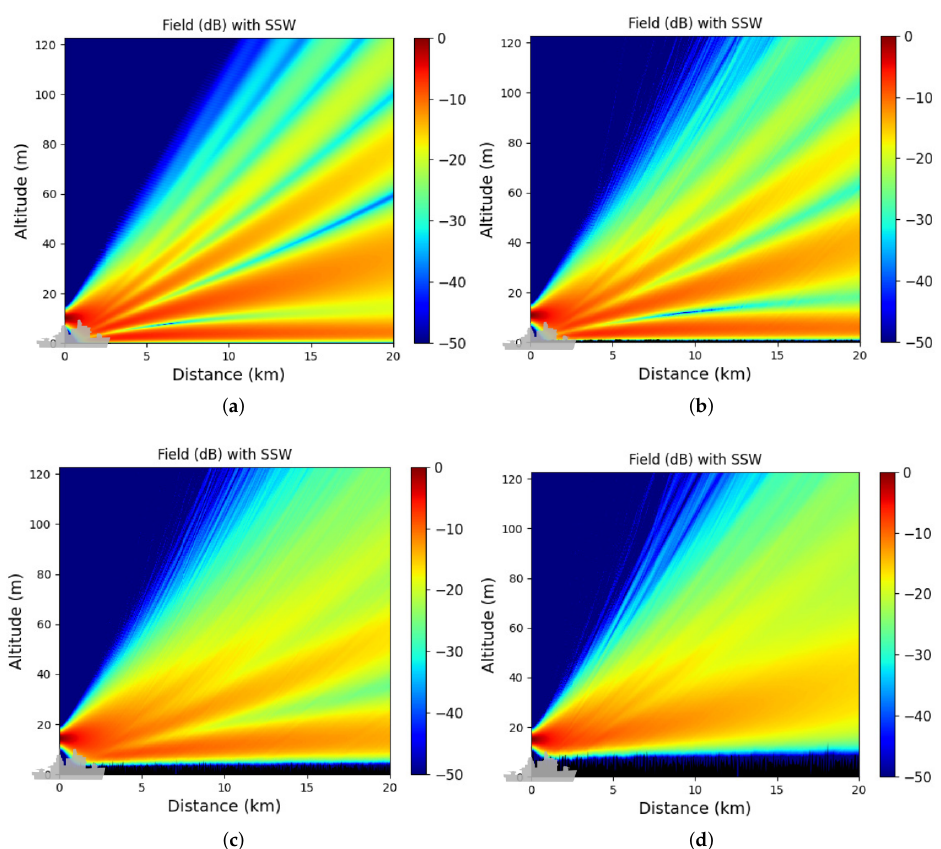
Figure 16. Means of the propagated fields over 50 Monte-Carlo simulations for different wind speeds. ( a ) U 10 = 5 m/s. ( b ) U 10 = 10 m/s. ( c ) 15 m/s. ( d ) 20